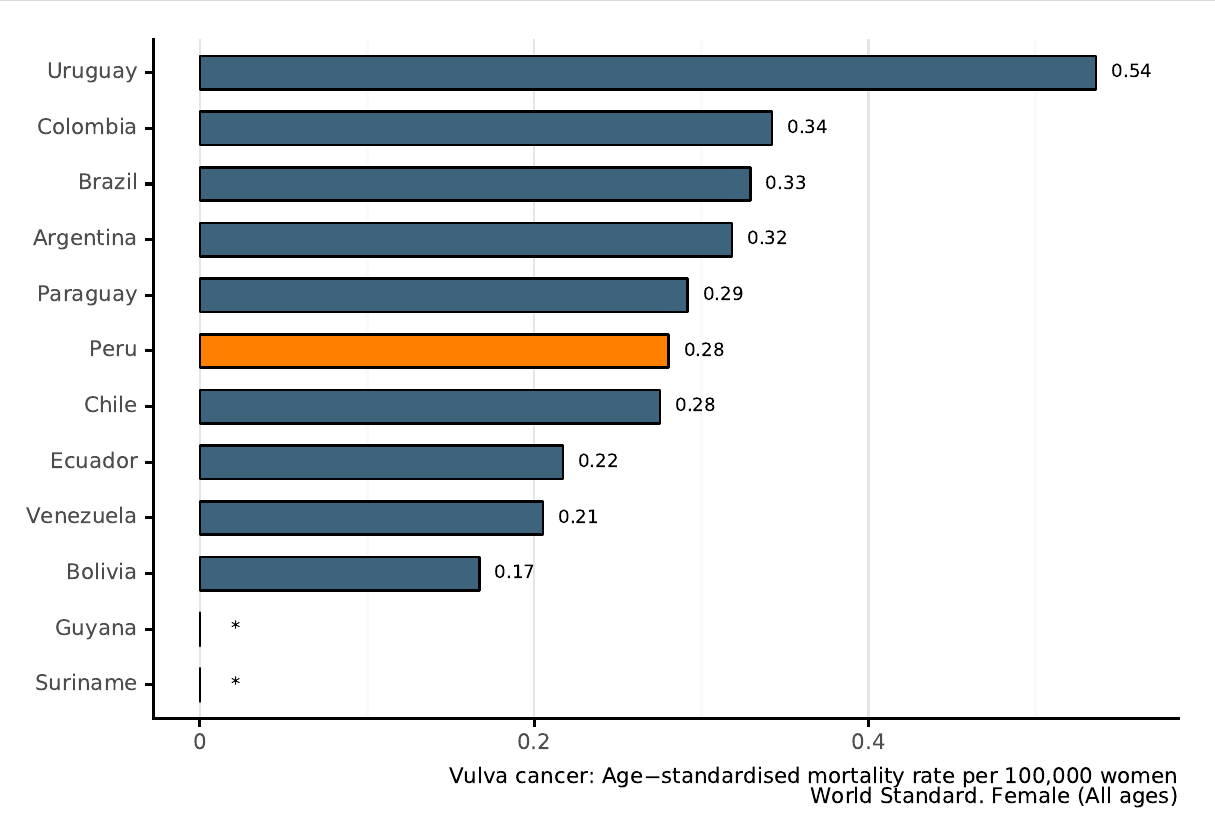
Figure 113: Age-standardised mortality rates of vulva cancer of Peru (estimates for 2020)